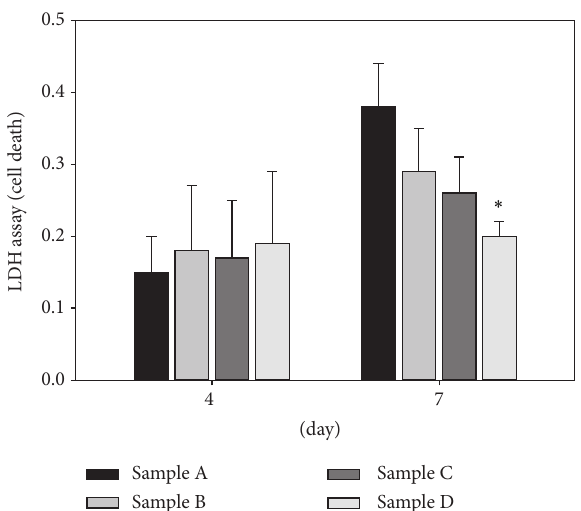
Figure 3: LDH assay was performed to evaluate the viability of the primary osteoblastic cells when exposed to the testing materials (samples A–D). While the cell death rate was low on all the groups at early days, elevated cell death was observed on samples A to C after 7-day culture except in the sample D group ( ∗ 𝑃 < 0.05 ).